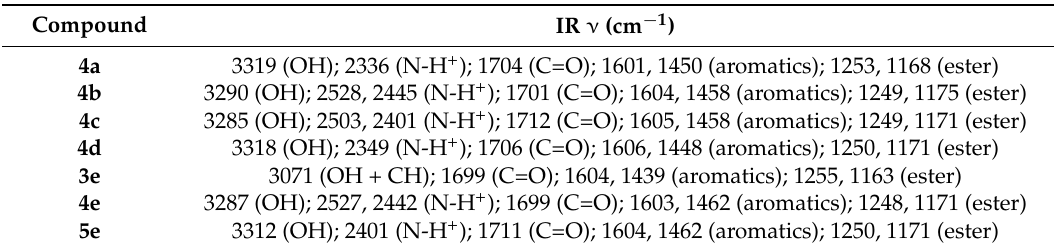
Table 1. Experimentally determined IR data of discussed